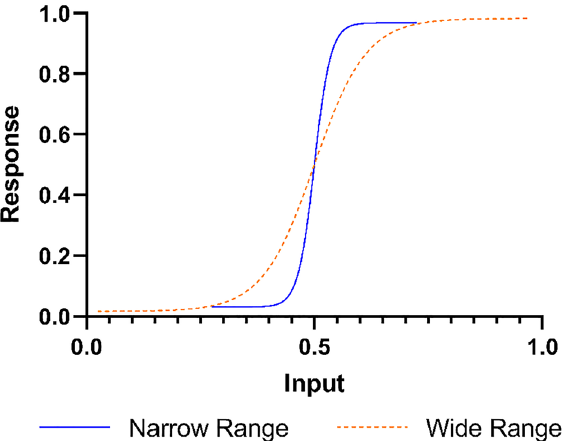
Figure 1. Schematic of range adaptation. With range adaptation, the responses (neural and behavioral output) are adjusted to the most likely input range, resulting in steeper response functions for a narrow range compared to a wide range.